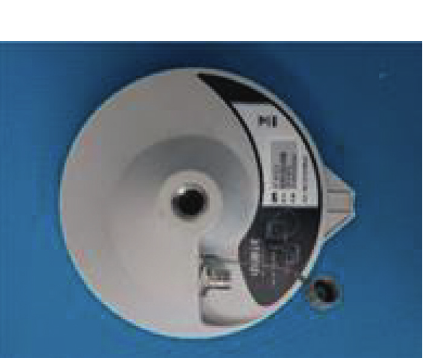
Figure 4: The unmanned surface vehicle (USV).